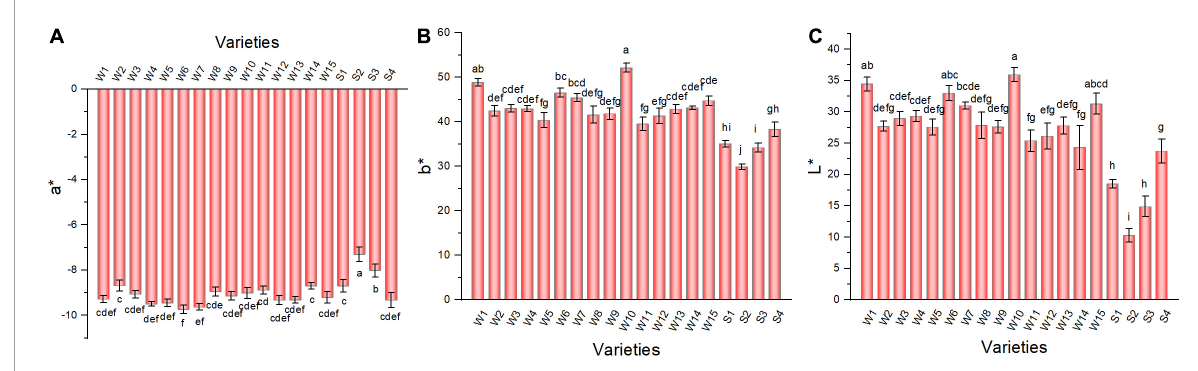
FIGURE3 The a* (A) , b* (B) , and L* values (C) of pepper varieties. Data are presented as mean ± SE. Different lowercase letters indicate statistical significance according to Duncan’s multiple range test ( p < 0.05). W1, Fengshouxianjiao; W2, Sujiao 8; W3, Qingan 7; W4, Sujiao 18; W5,